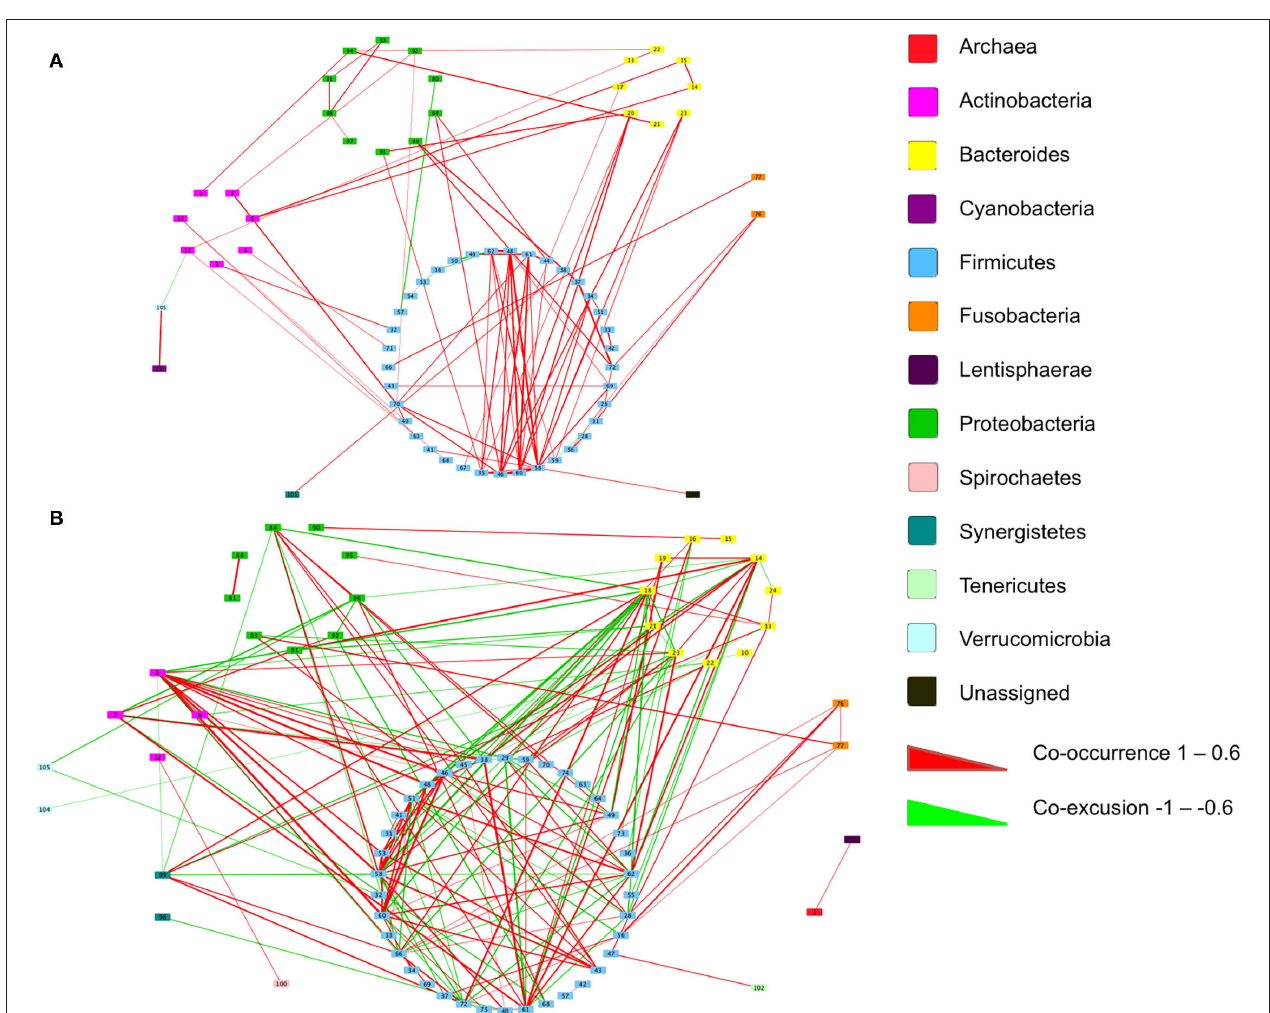
FIGURE 5 | Co-occurrence networks of taxa grouped by phyla in the samples of patient with CRC. Relationships with a correlation > 0.6 or < − 0.6 and an adjusted p < 0.05 are presented from (A) normal BMI samples and (B) high BMI samples. Co-occurrence (red) and co-exclusion (green) relationships are represented by weighted edges, based on the strength of the correlation. Taxa corresponding to each identification number are available in Additional File 1 .